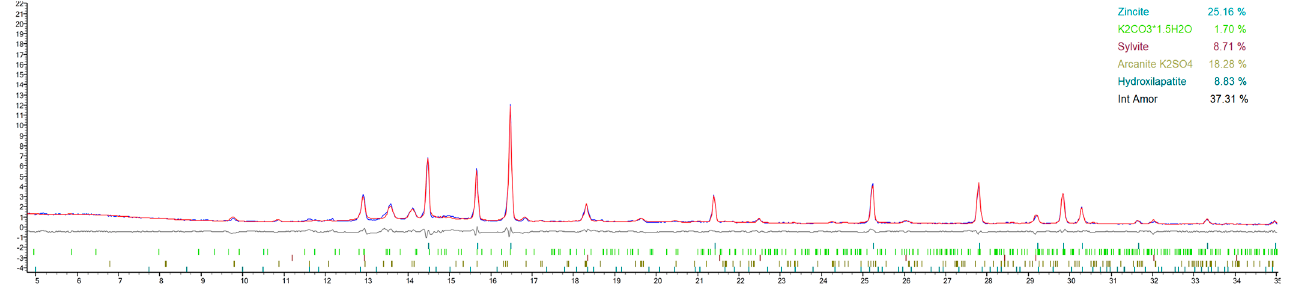
Figure 2. Results of X-ray diffraction of biomass bottom ash.